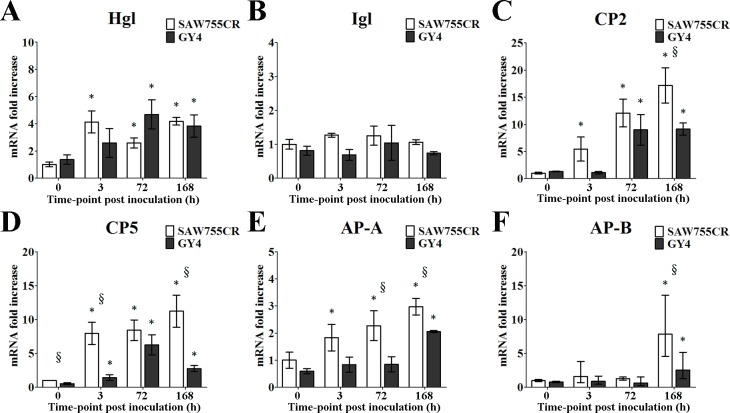
Quantitative real-time PCR assays of expression of Hgl (A), Igl (B), CP2 (C), CP5 (D), AP-A (E) and AP-B (F) from E. histolytica or E. nuttalli in ALAs of hamsters. Expression levels of genes for virulence factors of trophozoites in liver tissues from hamsters inoculated with E. nuttalli GY4 trophozoites are shown as 2-ΔΔCt for the target gene relative to ameba β-actin and normalized with the corresponding values from E. histolytica at 0 h, 3 h, 72 h, 168 h post-inoculation. Y axes are numbers correspond to the fold increase over 1.0, assigned to 0 h with E. histolytica. Error bars are standard errors of the mean calculated from three independent replicates. The abscissa shows the time post-inoculation. * P < 0.05 vs. 0 h, § P < 0.05 for E. nuttalli GY4 vs. E. histolytica SAW755CR.